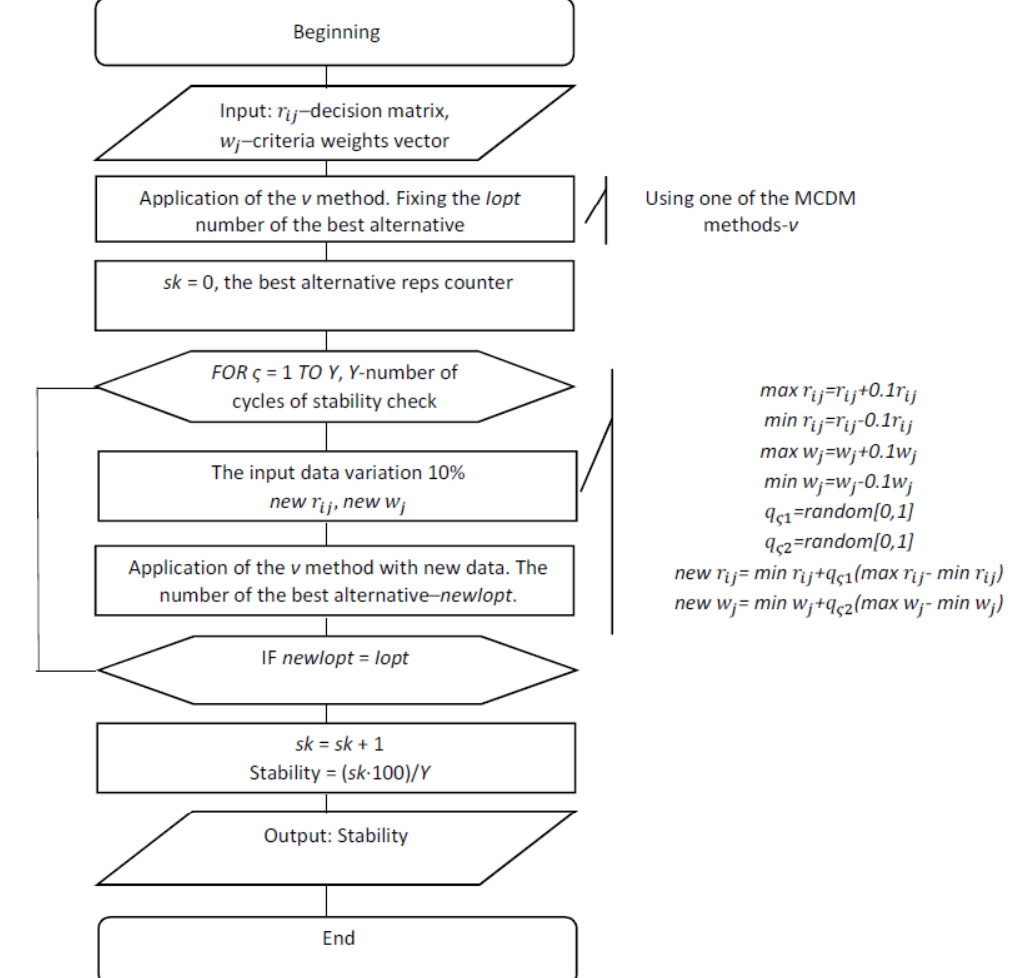
Figure 2. The algorithm for evaluating the stability of the Multi-Attribute Decision-Making (MADM) method.